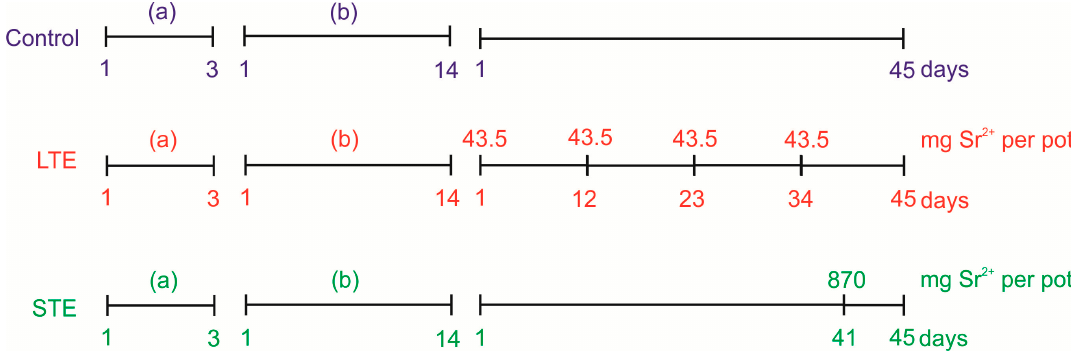
Figure 6. Experimental design: ( a ) seed germination; ( b ) Glycine max L. seedling growth in